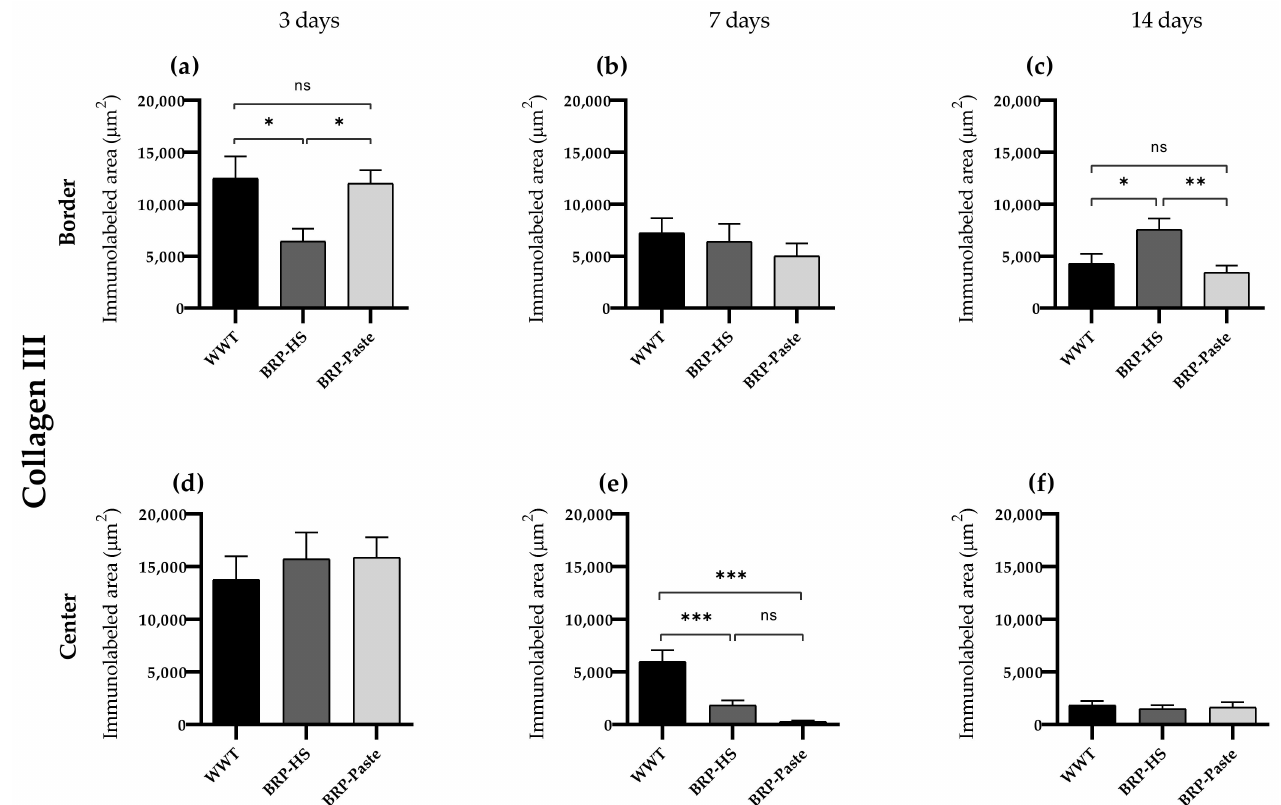
Figure 7. Quantification of collagen type III by immunolabed area ( µ m 2 ) at border ( a – c ) and central ( d – f ) regions (dermis) of the wounds in each experimental group for the periods of 3 ( a , d ), 7 ( b , e ) and 14 ( c , f ) days of treatment. Statistical difference compared to the WWT group was obtained by one-way ANOVA followed by Newman-Keuls test in which * p < 0.05, ** p < 0.01, and *** p < 0.001 ( n = 6). ns = no